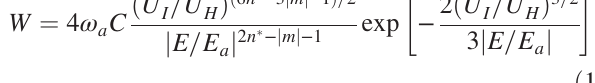
¼ 1 . 17 , 92 fs FWHM 0 . z ¼ 0 . 4 μ m, i ¼ 5 μ m) i